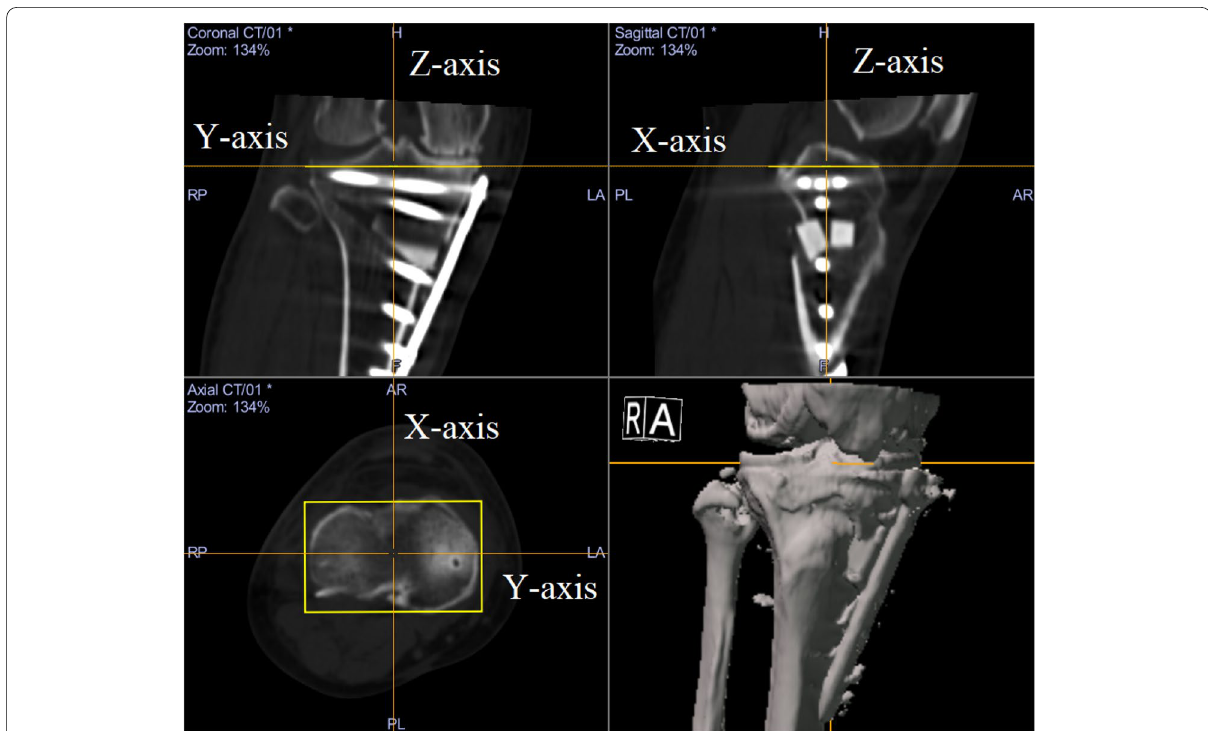
Fig. 5 To evaluate the locking plate position on postoperative CT images, the coordinate system was defined around a virtual rectangle fitted onto the contour of the tibial plateau at the level above the proximal end of the fibula parallel to the tibial plateau. Anteroposterior, medial/lateral, and vertical axes was defined as the X-axis, Y-axis and, Z-axis, respectively